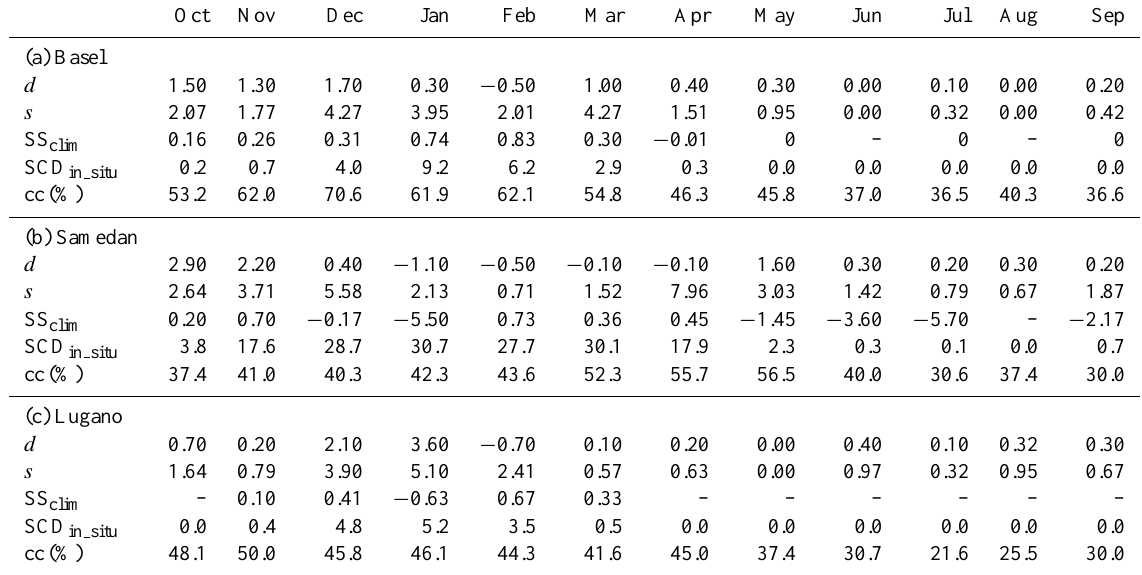
Table 3. Mean difference of SCD MODIS − SCD in situ ( d ) and standard deviation of the difference ( s ) as well as the Climatological Skill Score (SS clim ) . The number of snow days (SCD in situ ) and the cloud cover in percent (cc) averaged over each month for the 10yr and each station site is added. It is not possible to calculate SS clim when the Mean Squared Error (MAE) is zero (no snow days observed in all month over the